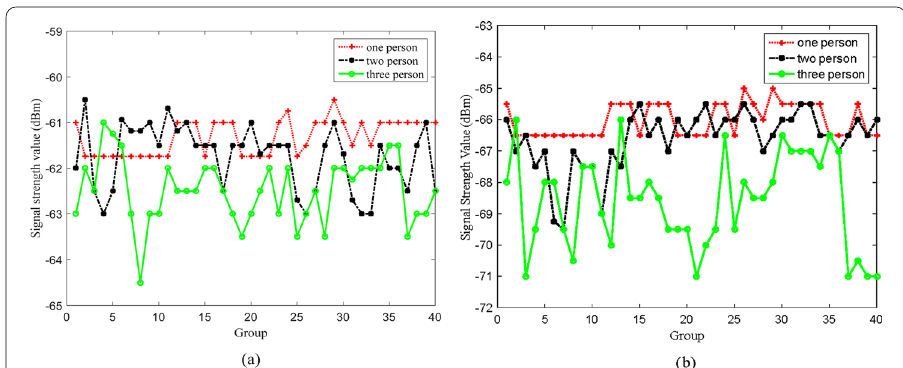
Fig. 4 a RSS comparison diagram of the 70th wireless link and b RSS comparison diagram of the 100th wireless